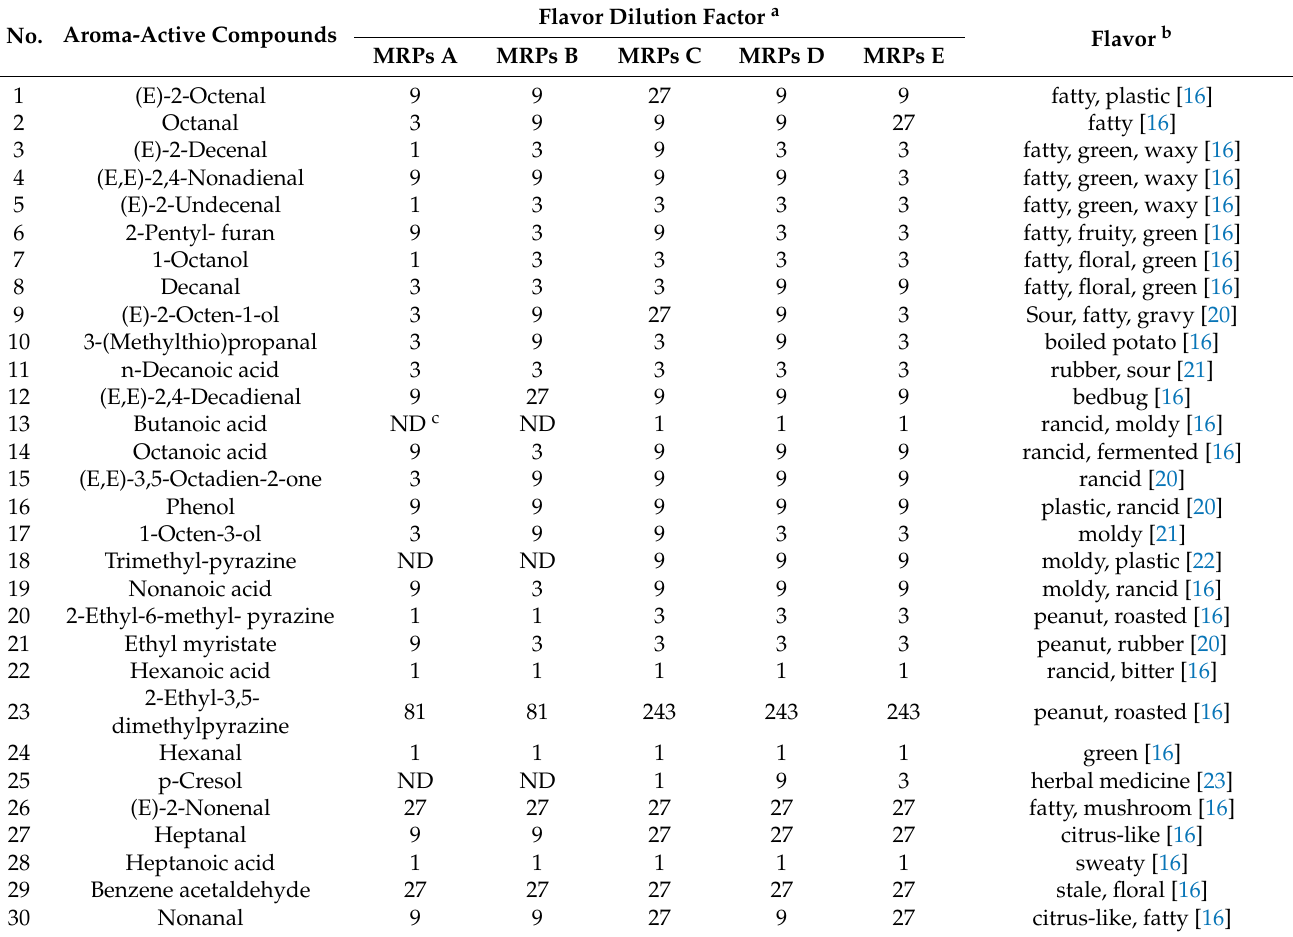
Table 1. Order contribution of volatile compounds of